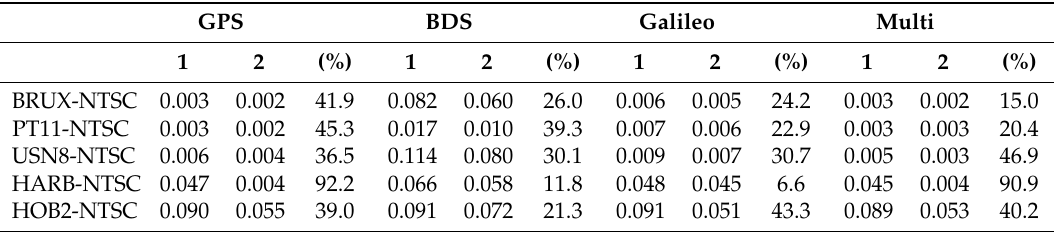
Table 6. Time link residuals of scheme1 and scheme2 compared with vondrak smoothing values using COD products (ns).